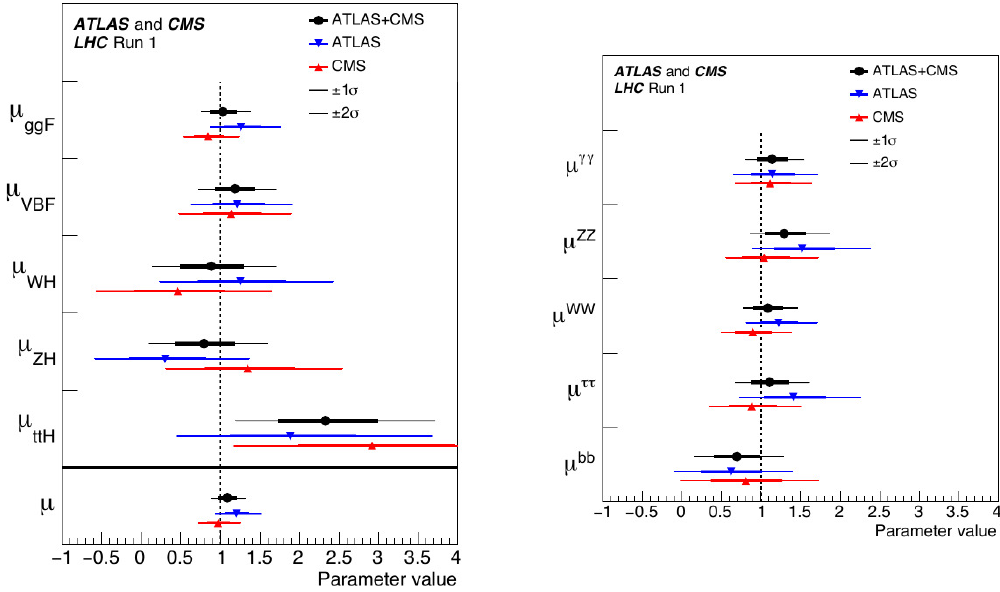
Figure 8. Production and decay rates of the Higgs boson and constraints on its couplings as compared to their predictions by the standard model from a combined ATLAS and CMS analysis of the LHC p-p √ s = 7 and 8 TeV collision data at